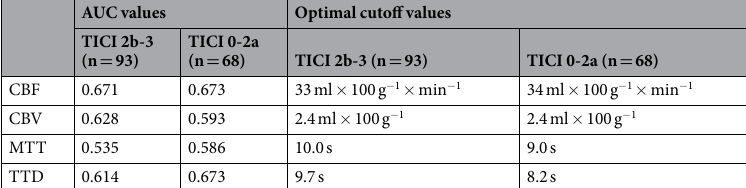
Table 2. Area under the receiver operating characteristics curve (AUC) values to determine infarction and optimal cutoff values (thresholds) of perfusion parameters.